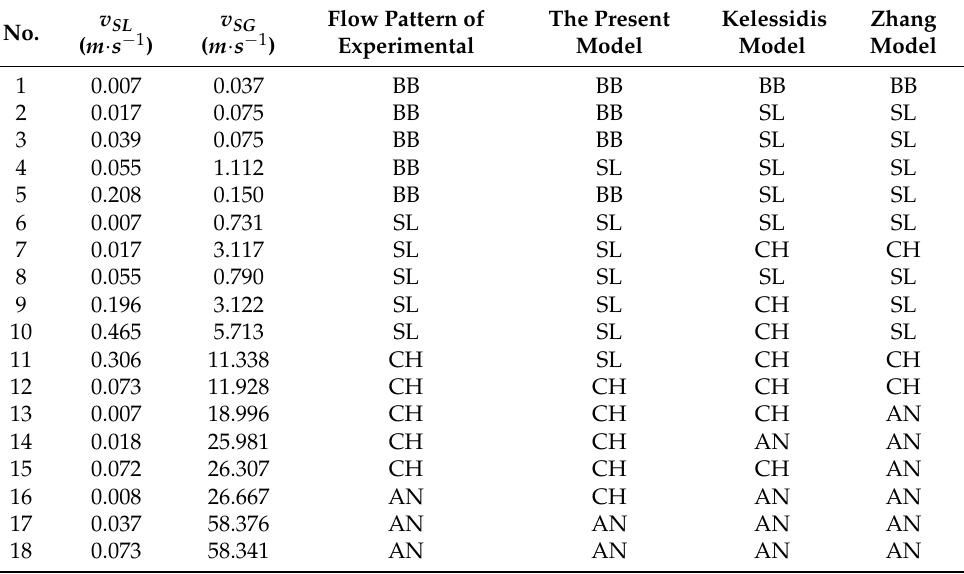
Table 3. Comparison of model predictions with experimental results at an inclination angle of 60 ◦